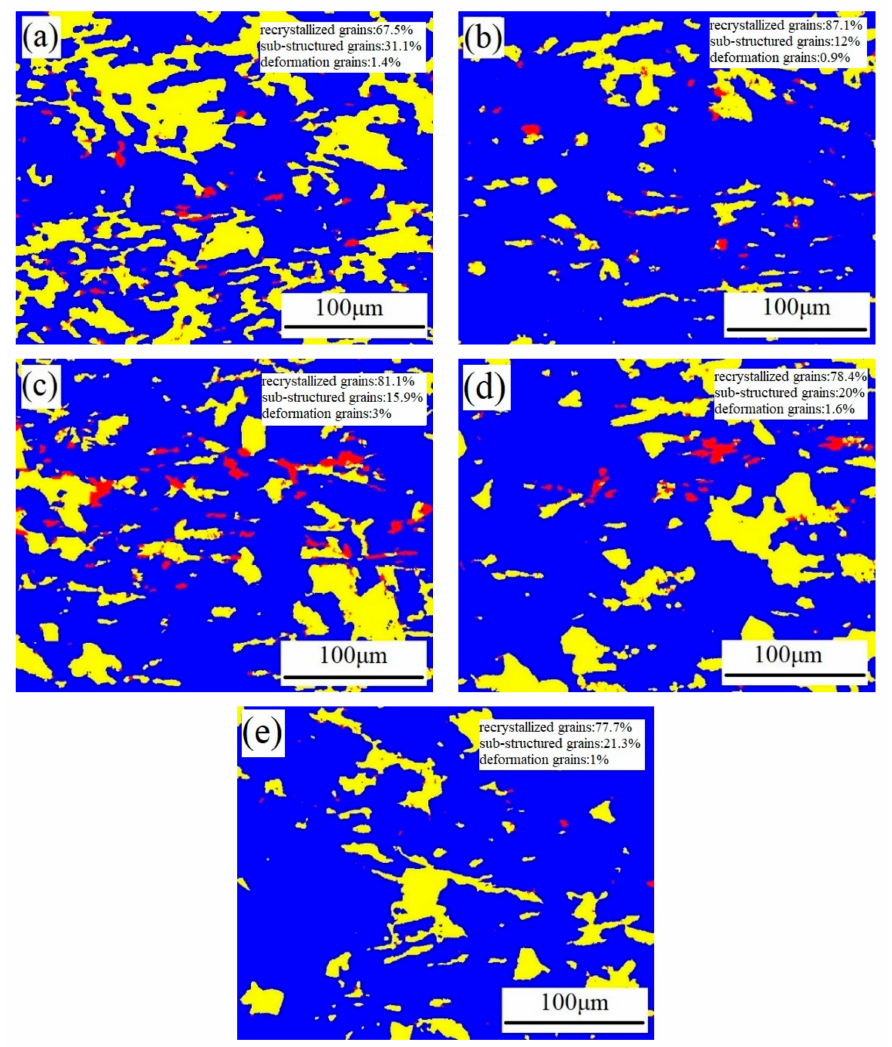
Figure 9. Recrystallized maps of 7085 and TiC / 7085 after T6 treatment ( a ) 7085; ( b ) 0.1 wt% TiC / 7085; ( c ) 0.3 wt% TiC / 7085; ( d ) 0.5 wt% TiC / 7085; ( e ) 1 wt% TiC /